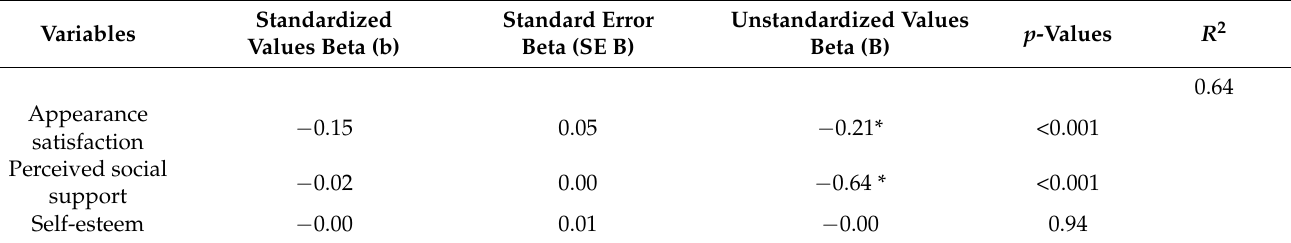
Table 3. Regression analysis for the variables that predict patients’ general level of psychopathology at the follow-up research